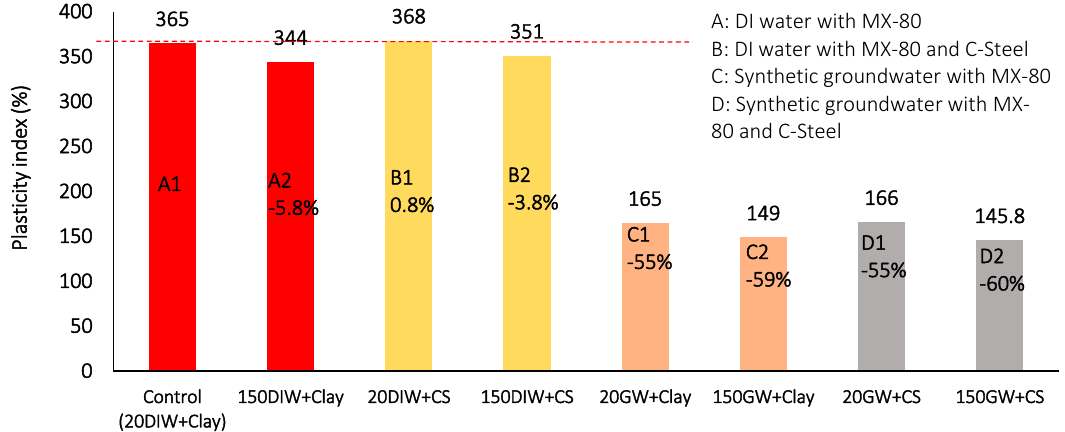
Figure 20. Plasticity index results at 20 °C and 150 °C for combinations of MX-80, De-Ionised water or synthetic groundwater and carbon steel. (The number before the batch code represents the maximum thermal exposure temperature, the lettering system refers to the key, above, for a description of each batch configuration)